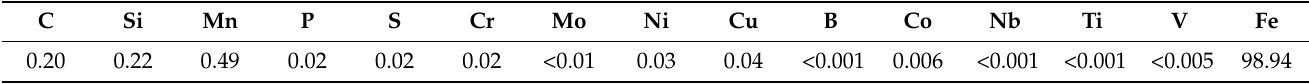
Figure 1. A customized hanging ring. Table 1. Chemical composition of experimental hanging ring Table 1. Chemical composition of experimental hanging ring (wt.%).